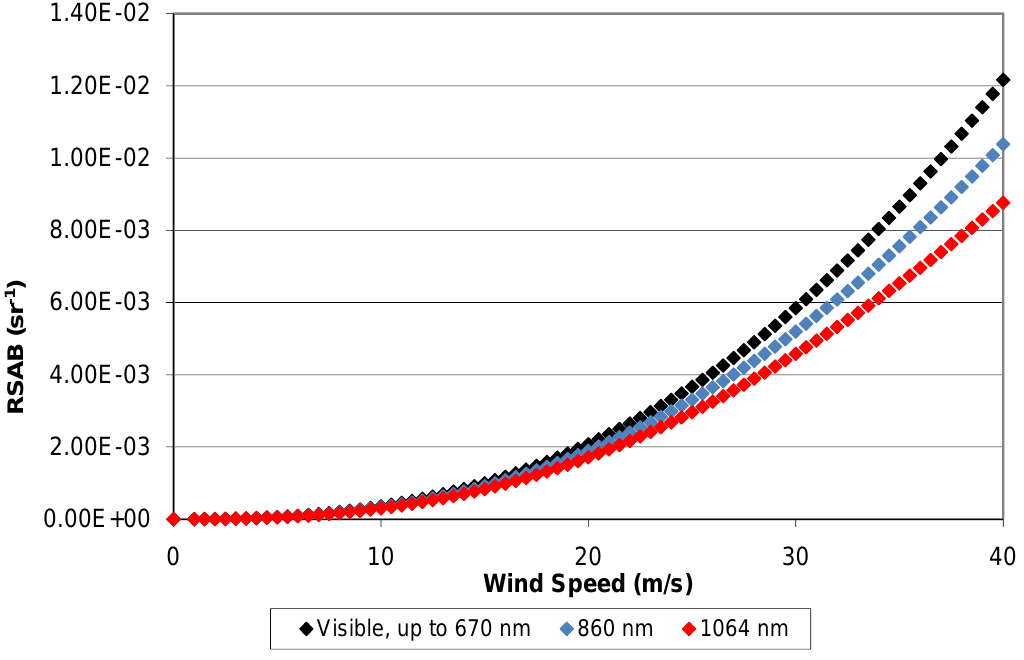
Figure 2. Model of backscatter due to Lambertian scattering from foam. Three wavelengths are shown. The black curve shows the model of Moore et al. [32] for visible wavelengths up to 670 nm (Equation (6)). This model is used for the 532 nm laser light. The blue curve is the model of Moore et al. [32] for 860 nm shortwave infrared (Equation (7)). The red curve shows an extrapolated model for 1,064 nm, created as described in the text as an exponential decay with wavelength perfectly fitting the two shorter-wavelength models. (Equation (8), where λ = 1,064